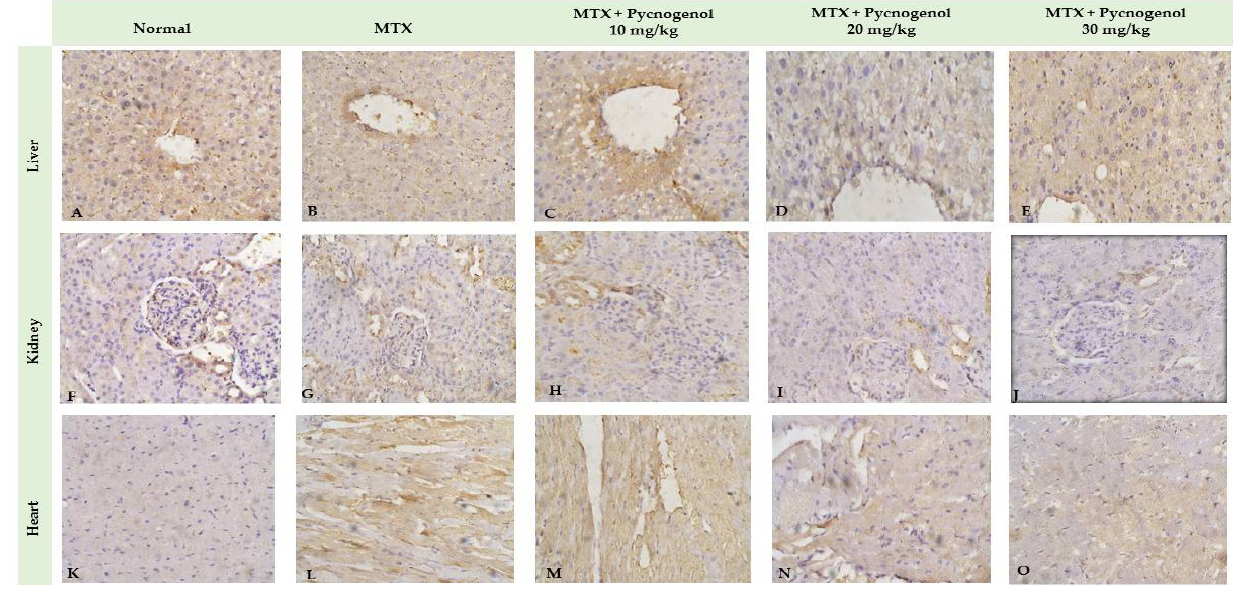
Figure 8. Immunohistochemical staining with IHC-caspase 3 of liver ( A – E ), kidney ( F – J ), and heart ( K – O ) tissue. Differences assessed by Kruskal–Wallis test at p = 0.05.